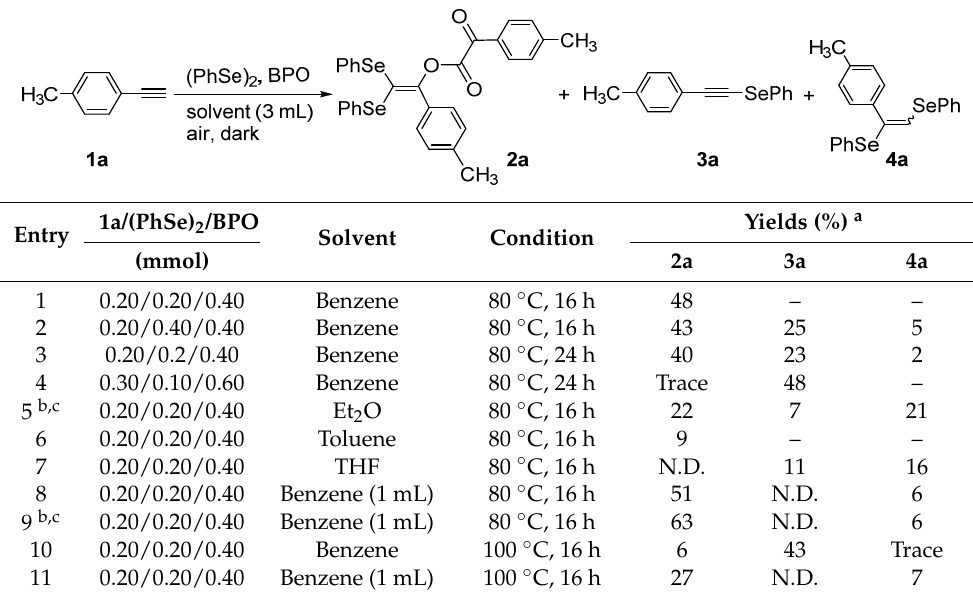
Table 1. Optimization of the reaction conditions for the synthesis of 2a